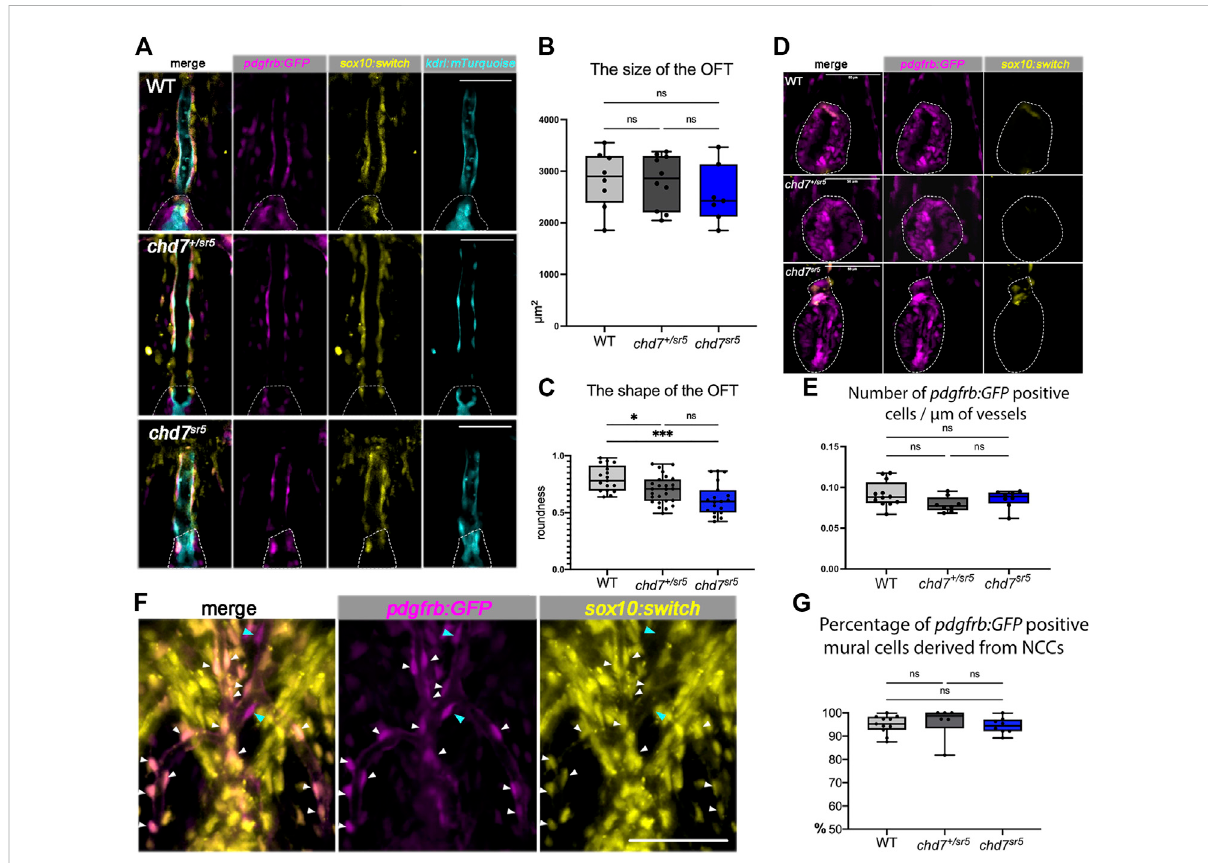
FIGURE 5 Cardiac NCCs and mural cells are not affected inthe VA and OFT of chd7 sr5 mutants at 7dpf. (A) sox10:switch (pseudo-colored yellow) positive NCCs contribute to pdgfrb:GFP (pseudo-colored magenta) positive mural cells around the VA in WT , chd7 +/sr5 , and chd7 sr5 fi sh. 40X single-slice confocalimagesatthethickestzpositionoftheVA.DottedlinescircledtheOFT. (B) Quanti fi cationofthesizeoftheOFTin WT,chd7 +/sr5 ,and chd7 sr5 fi sh. (WT: n = 8, chd7 +/sr5 : n = 10, and chd7 sr5 : n = 7). (C) Roundness analysis of the shape of OFT in WT , chd7 +/sr5 , and chd7 sr5 fi sh. (WT: n = 17, chd7 +/sr5 : n = 26, chd7 sr5 : n = 19). (D) Very few sox10:switch- labeled NCCs contribute to the OFT (circled by the dotted lines). 40X single-slide confocal images at the widest z position of the OFT. (E) Quanti fi cation of the distribution of the pdgfrb:GFP- positive cells along the vessel.